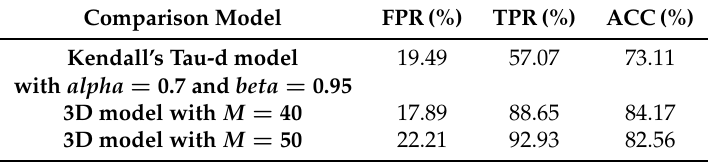
Table 1. The performance evaluation of the proposed model and Kendall’s Tau-d